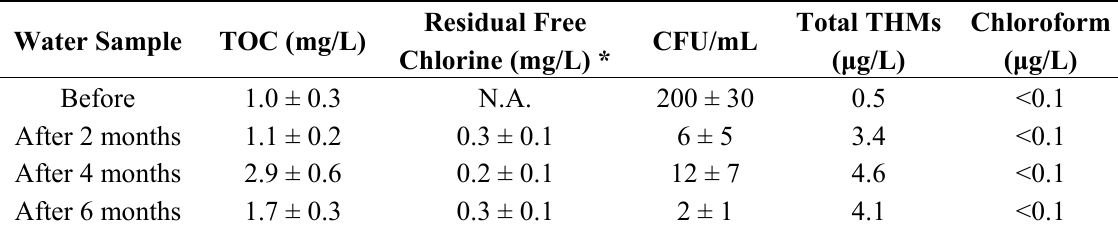
Table 2. Trend of water parameters, after the implementation of the disinfecting system, in the first months of